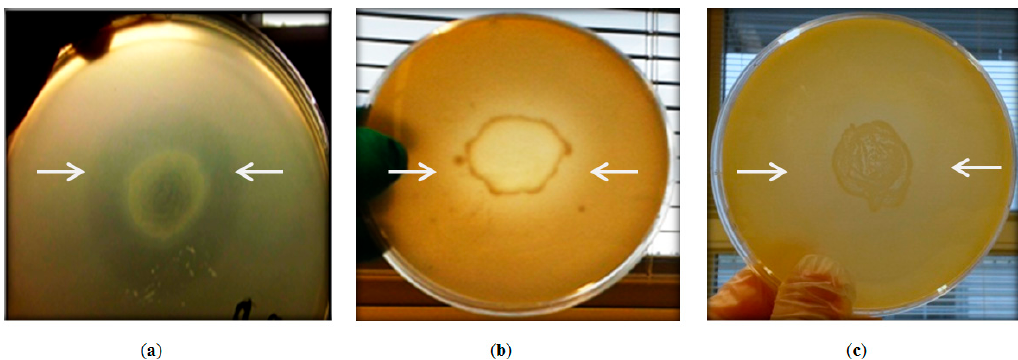
Figure 1. Antibacterial activity of Geobacillus sp. strain ZGt-1 against ( a ) G. stearothermophilus strain 10; ( b ) B. subtilis ; and ( c ) S. typhimurium CCUG 31969. The arrows are pointing to the inhibition zone.